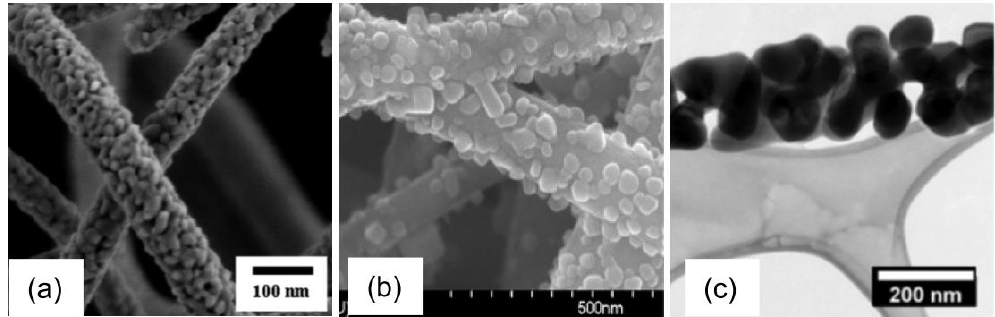
Figure 30. Morphology of some electrospun photo-catalyst materials. SEM images refer to ( a ) Table S2, 2, (reproduced from reference [230] with permission. Copyright 2012, Elsevier), ( b ) C-Co-TiC (reproduced from reference [234] with permission. Copyright 2017, Elsevier), and ( c ) Fe 2 O 3 (reproduced from reference [241] with permission. Copyright 2017, Elsevier) nanofibers.